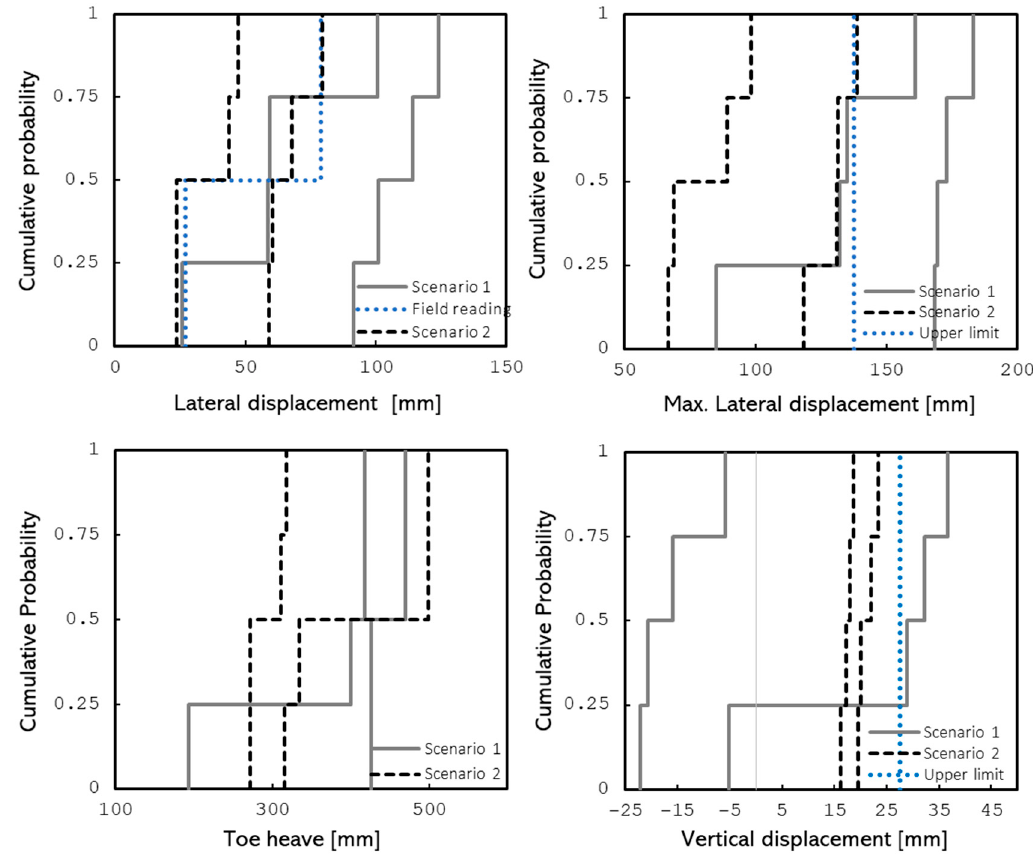
Figure 7. RSFEM modelling results on the p -Box; scenario 1: Stochastically dependent variables: water level and cohesion, scenario 2: Stochastically independent variables: water level and flow rate.